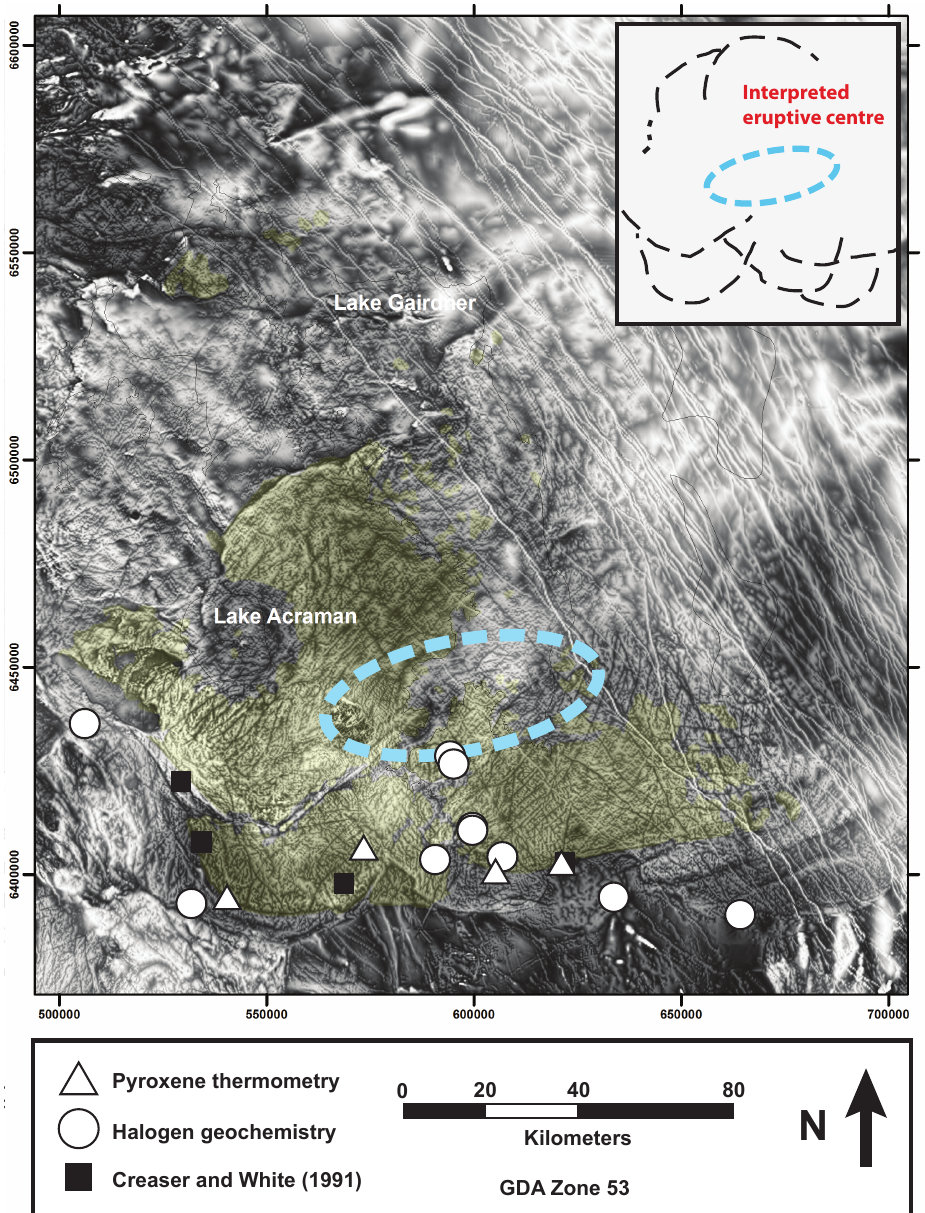
Fig. 2. Sample sites superimposed onto reduced-to-the-pole greyscale aeromagnetic image of the Gawler Range Volcanics. The lobe morphology of the lava flows can be observed as regions of similar magnetic texture defined by arcuate shapes. The (preserved) flow fronts closely follow the modern outcrop distribution (inset) in the SW and these shapes are also imaged undercover (NE of Lake